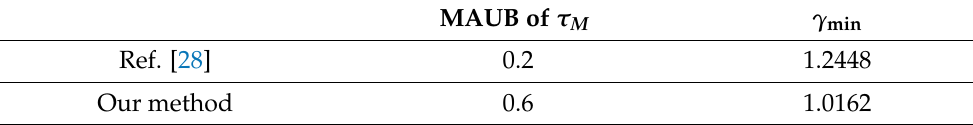
Table 1. Comparison